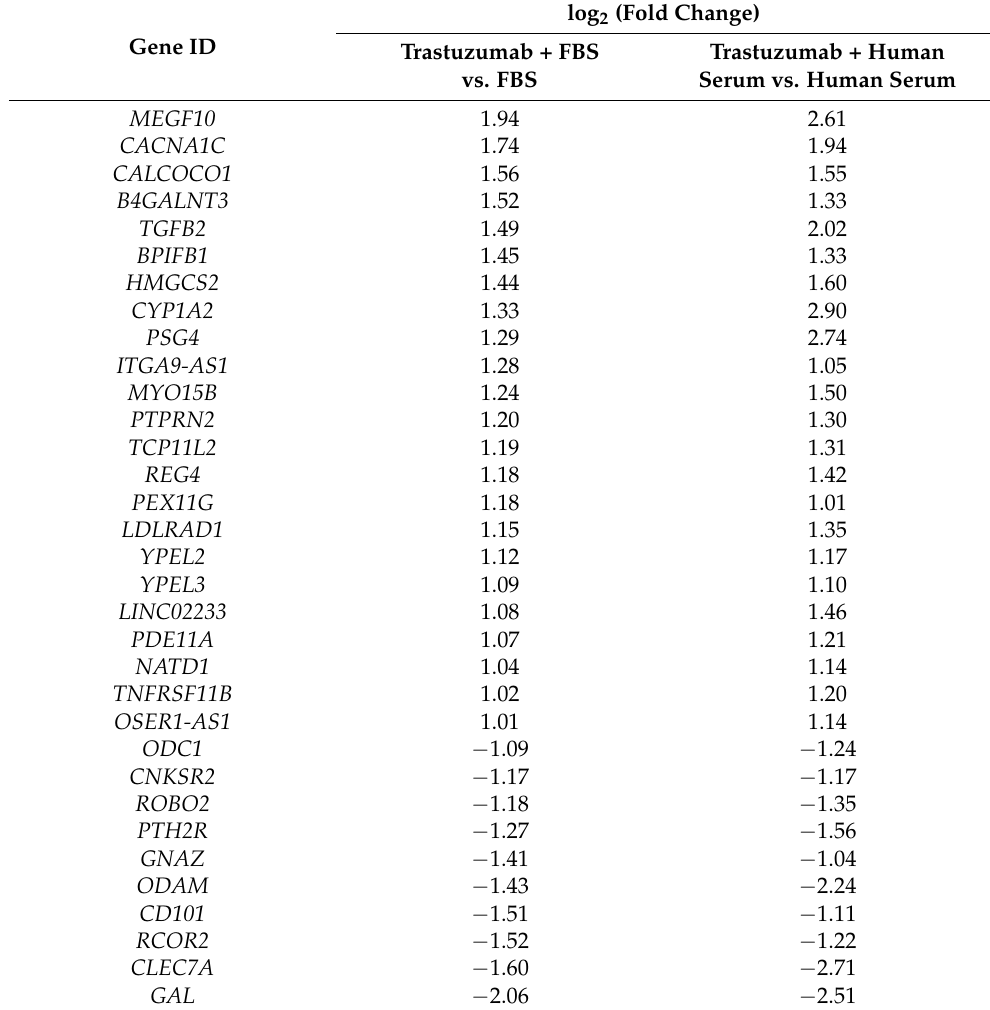
Table 2. Differentially expressed genes upon trastuzumab treatment of BT474 cells in the presence and in the absence of human serum, whose expression was not significantly changed in the comparison of trastuzumab vs. trastuzumab EGF treatment. log 2 (Fold Change) Gene ID Trastuzumab + FBS vs.